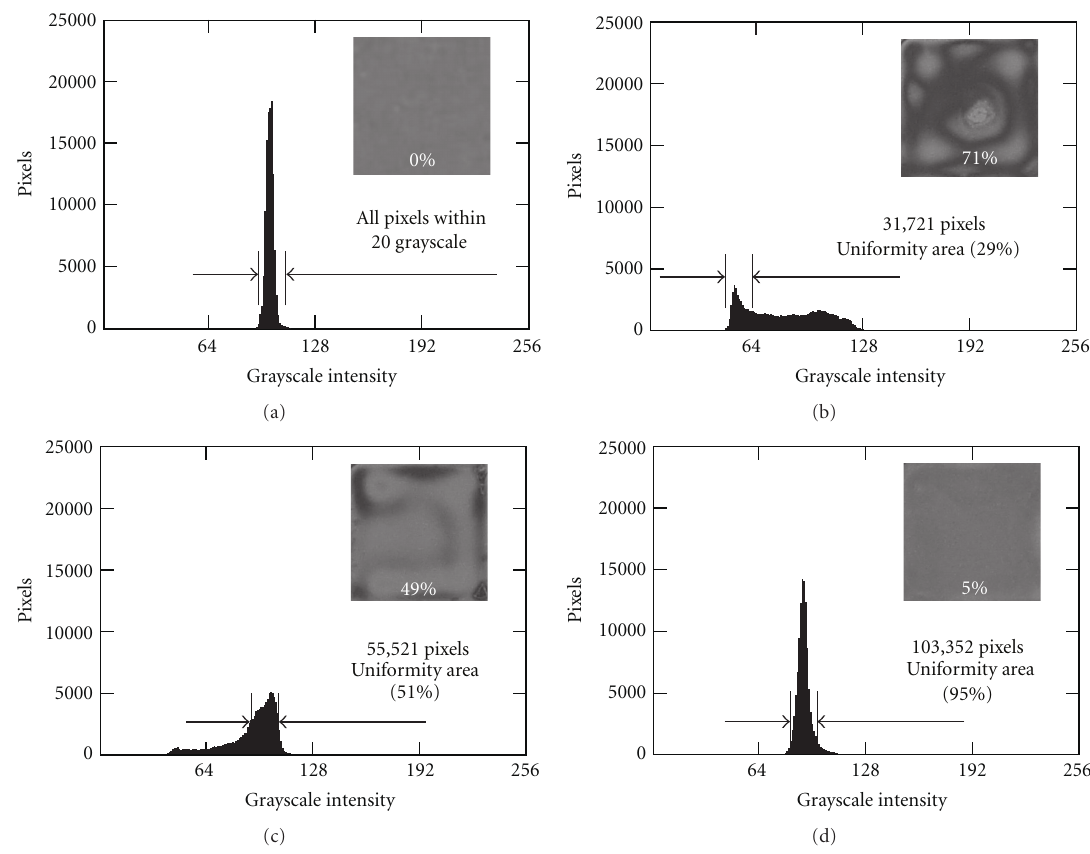
Figure 5: Examination of nonuniformity of the residual layer by gray-scale histogram: (a) reference gray-scale histogram, (b) with low- viscosity resin, nonuniformity of the residual layer was 71%, (c) with middle-viscosity resin, nonuniformity of the residual layer was 49%, and (d) with high-viscosity resin, nonuniformity of the residual layer was